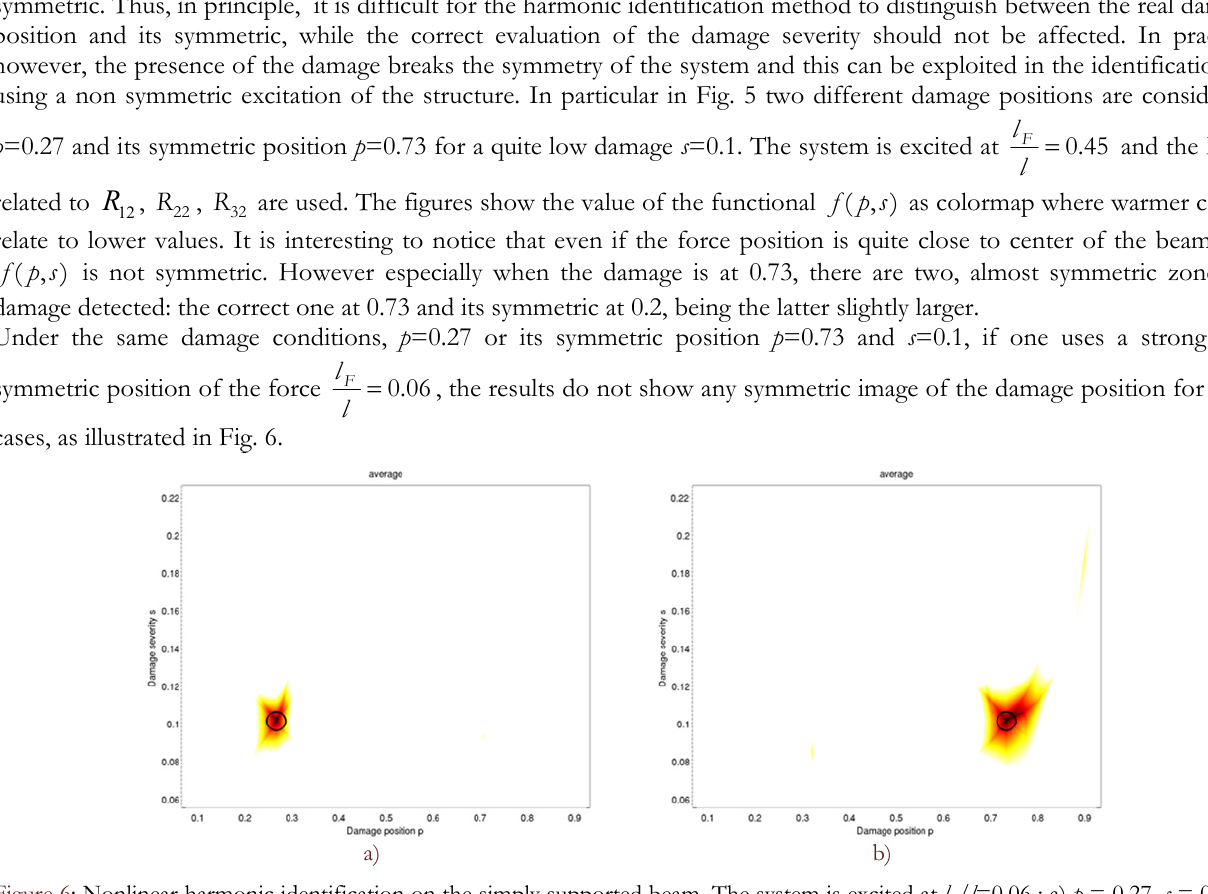
Figure 6: Nonlinear harmonic identification on the simply supported beam. The system is excited at l F / l =0.06 ; a) p = 0.27, s = 0.1; b) p =0.73 s =